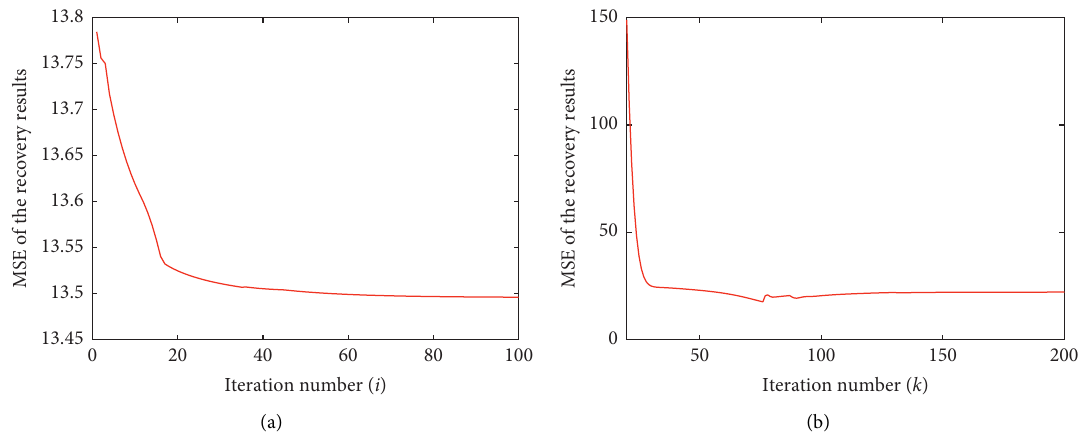
Figure 2: MSE of the reconstruction results with different numbers of iterations of i and k when M � N � 15 and SNR � 20 dB. (a) MSE with the iteration number i when k � 200. (b) MSE with the iteration number k when i �